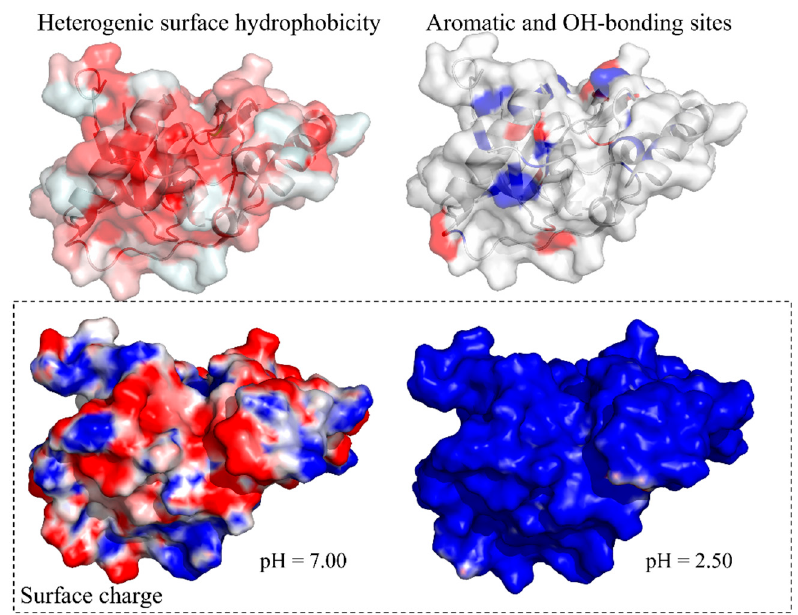
Figure 2. Peptide surface properties. Three-dimensional structure of a hydrolysing peptide represented by its accessible surface area. ( Top - left ) Red-coloured areas depict higher hydrophobicity. ( Top - right ) Blue and red show sites where π – π interactions and OH-bonding are possible, respectively.